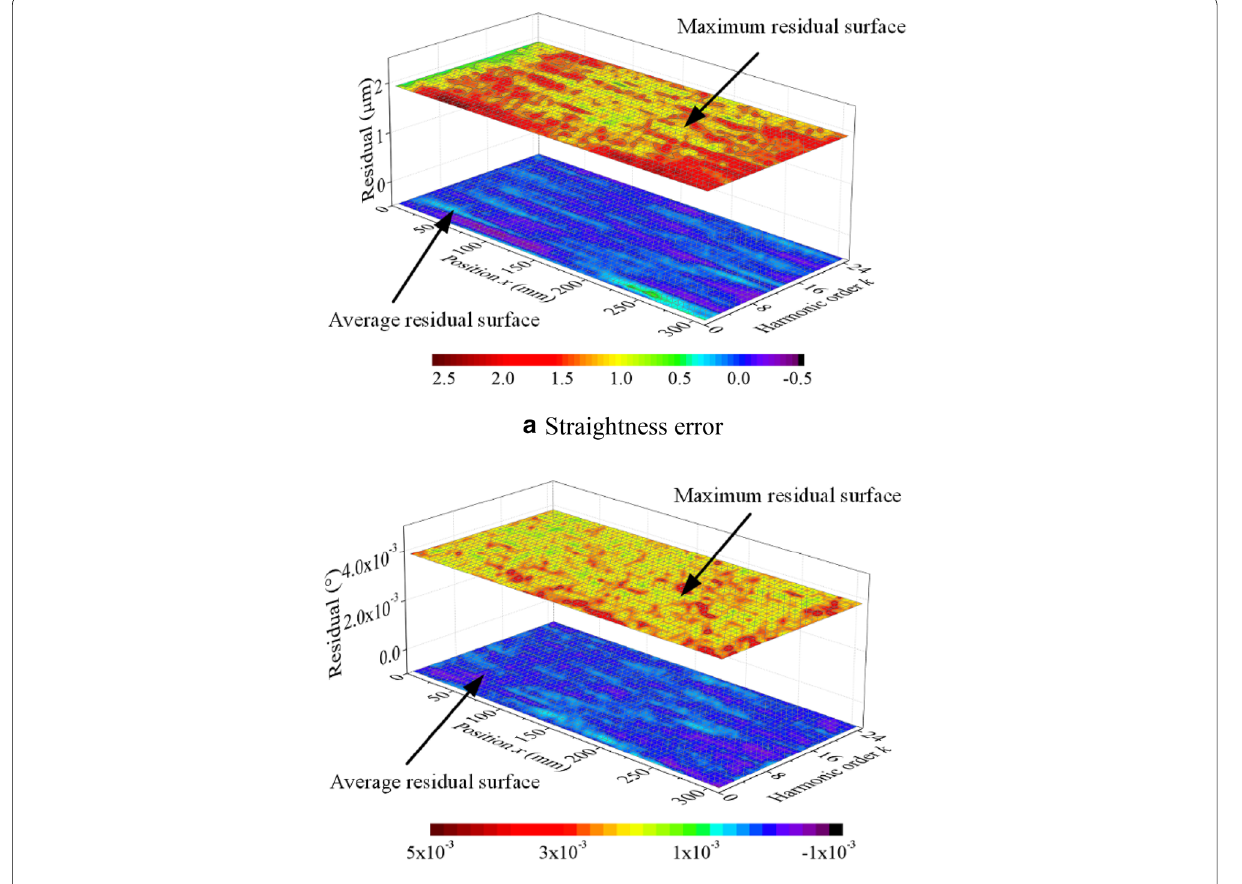
Figure 6 Variations of the average and maximum of the residuals caused by the noise ( σ